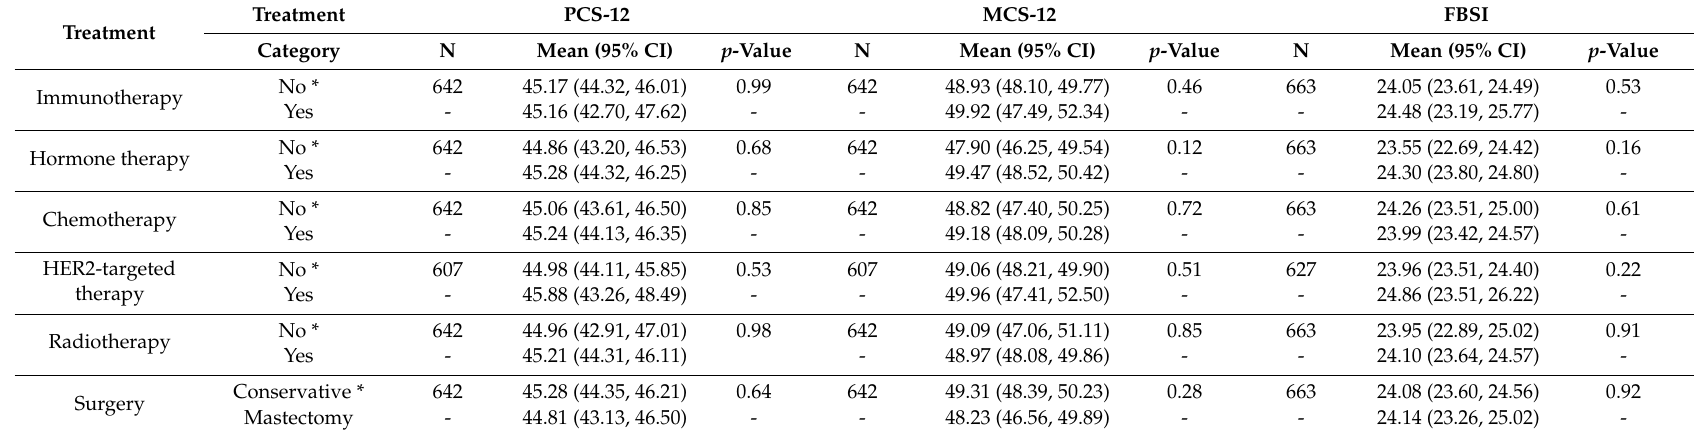
Table 3. Marginal means of health-related quality of life scores according to the treatment